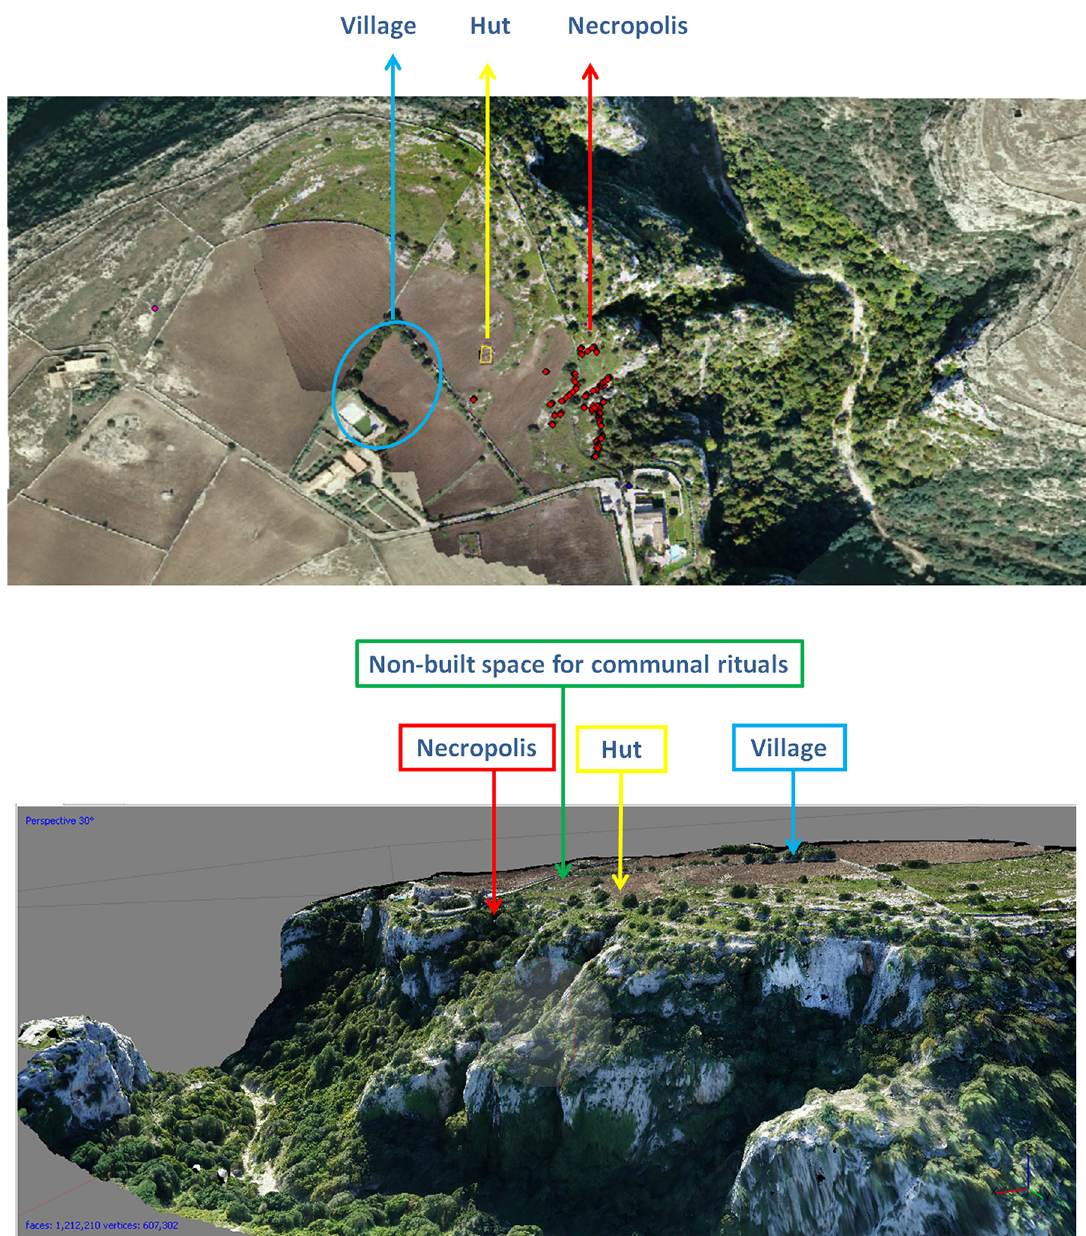
Figure 6. Calicantone. Ritual landscape: distribution of the archaeological